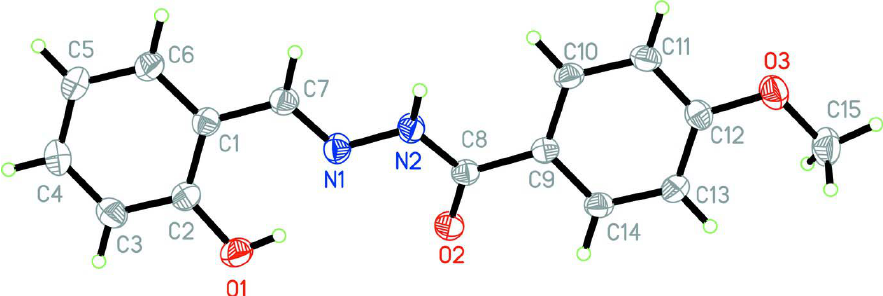
The molecular structure of the compound, showing the atom-numbering scheme. Displacement ellipsoids are drawn at the 30% probability